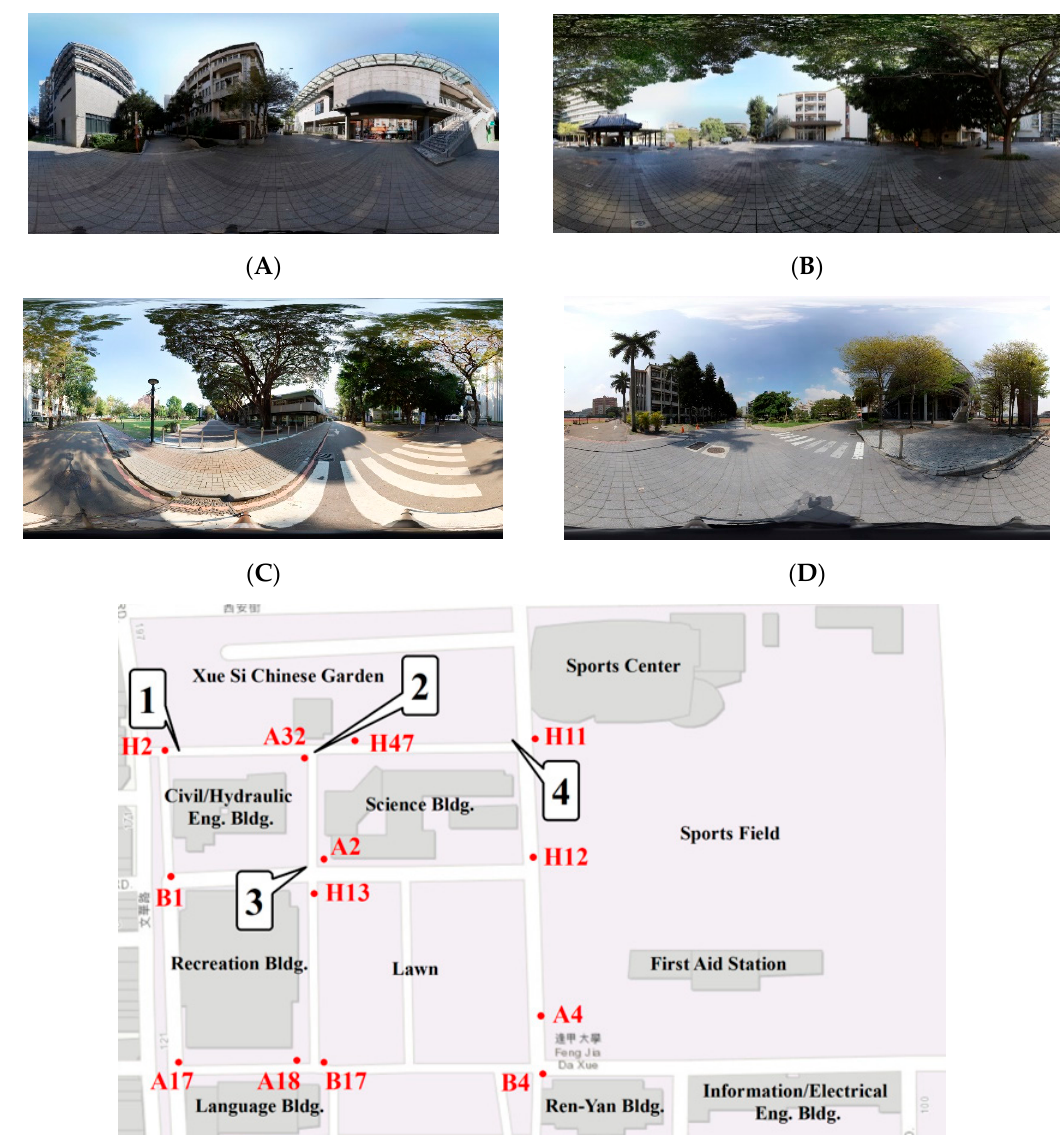
Figure 7. Examples of the stitched images, located ( A ) symbol 1, ( B ) symbol 2, ( C ) symbol 3, and ( D ) symbol 4 in ( E ).